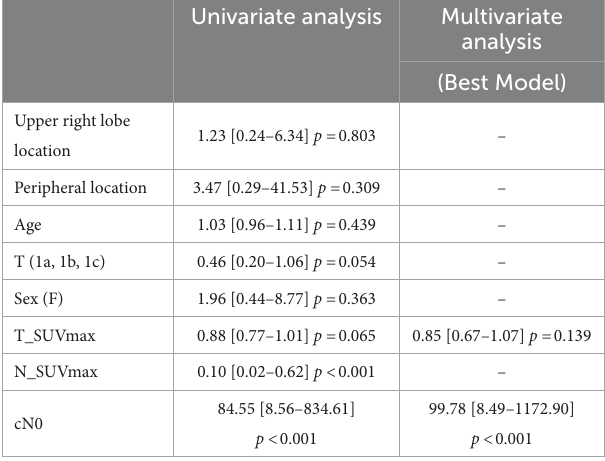
TABLE 2 Prediction of pN0 status in cT1M0 patients: univariate and multivariate